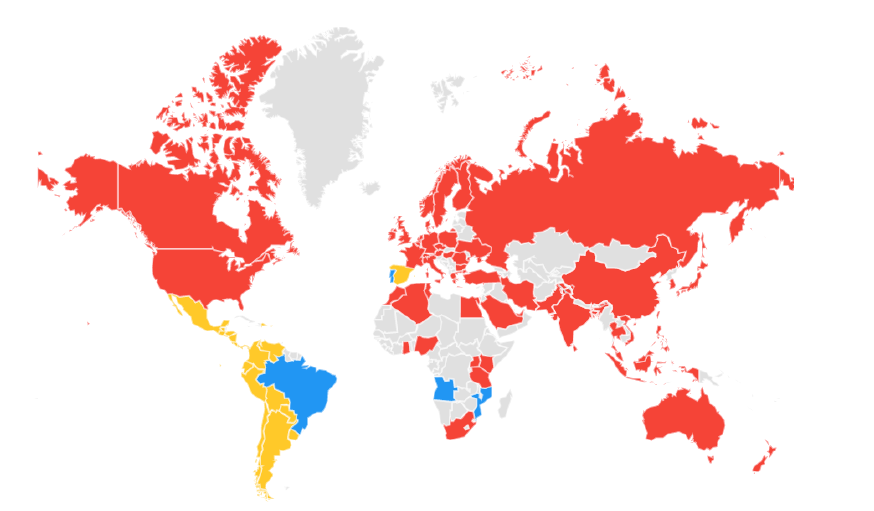
Fig. 2. Interest by region. Innovation (EN, FR, DE) - Red, Innovacion (ES) – Y ellow and Inovação (PT) – Blue as a search terms in https://trends.google.com for the last five